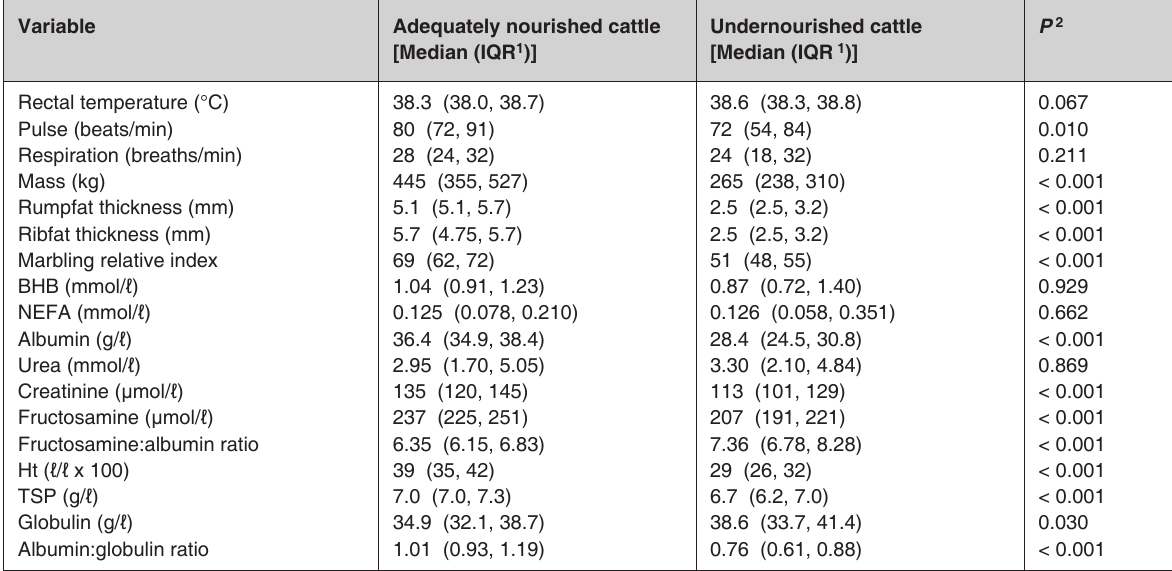
TABLE 1 Clinical, ultrasound and biochemical variables in adequately nourished and undernourished cattle: descriptive statistics and comparison between groups